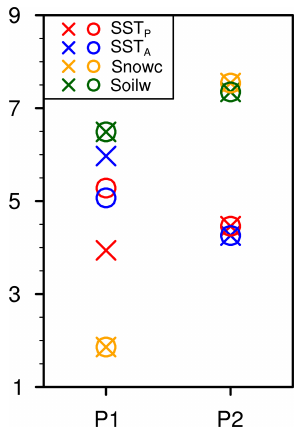
Figure 5. Composite of the simulated HD NC caused by the four external forcing factors (favored years minus unfavored years). The circles and crosses represent the original and detrended sequences,